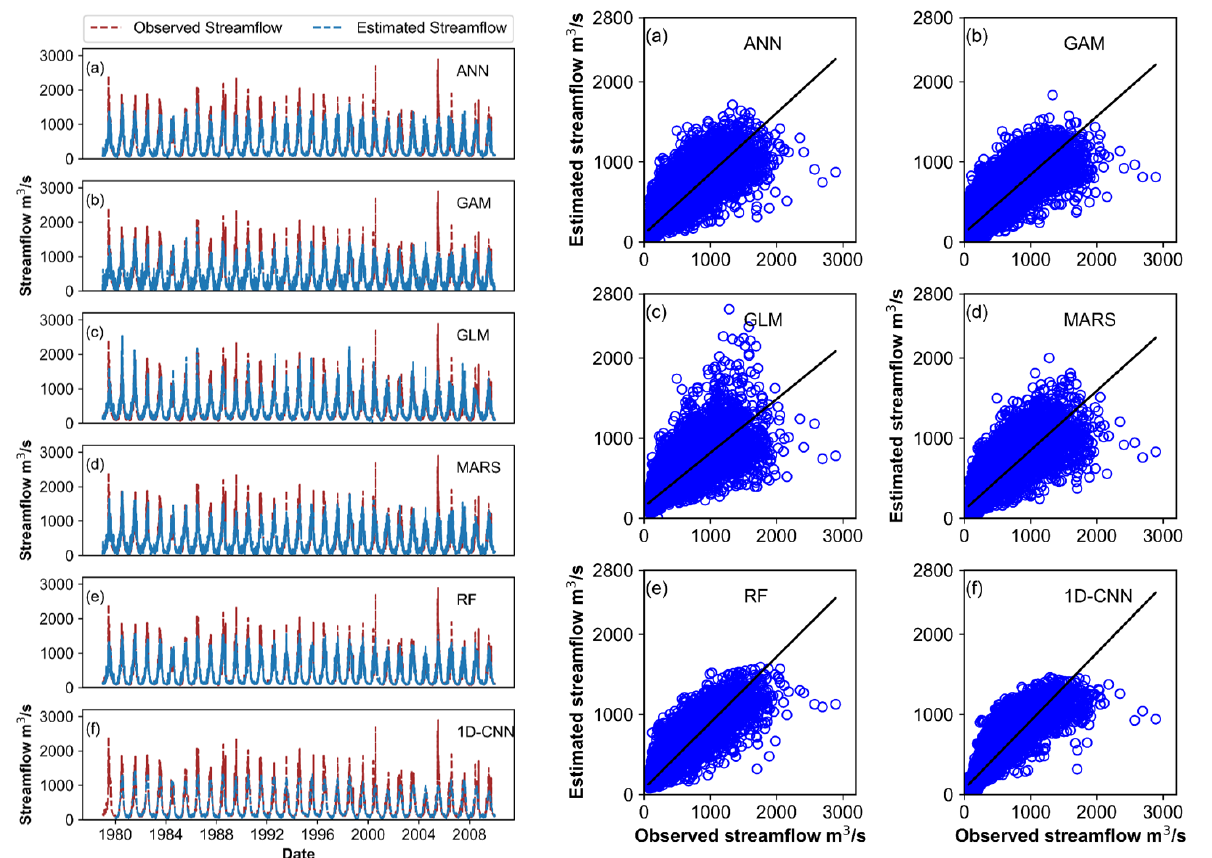
Figure 6. A comparison of observed and simulated streamflow for all six models (ANN, GAM, GLM, MARSs, RF, and 1D-CNN) under rainfall scenarios R 1